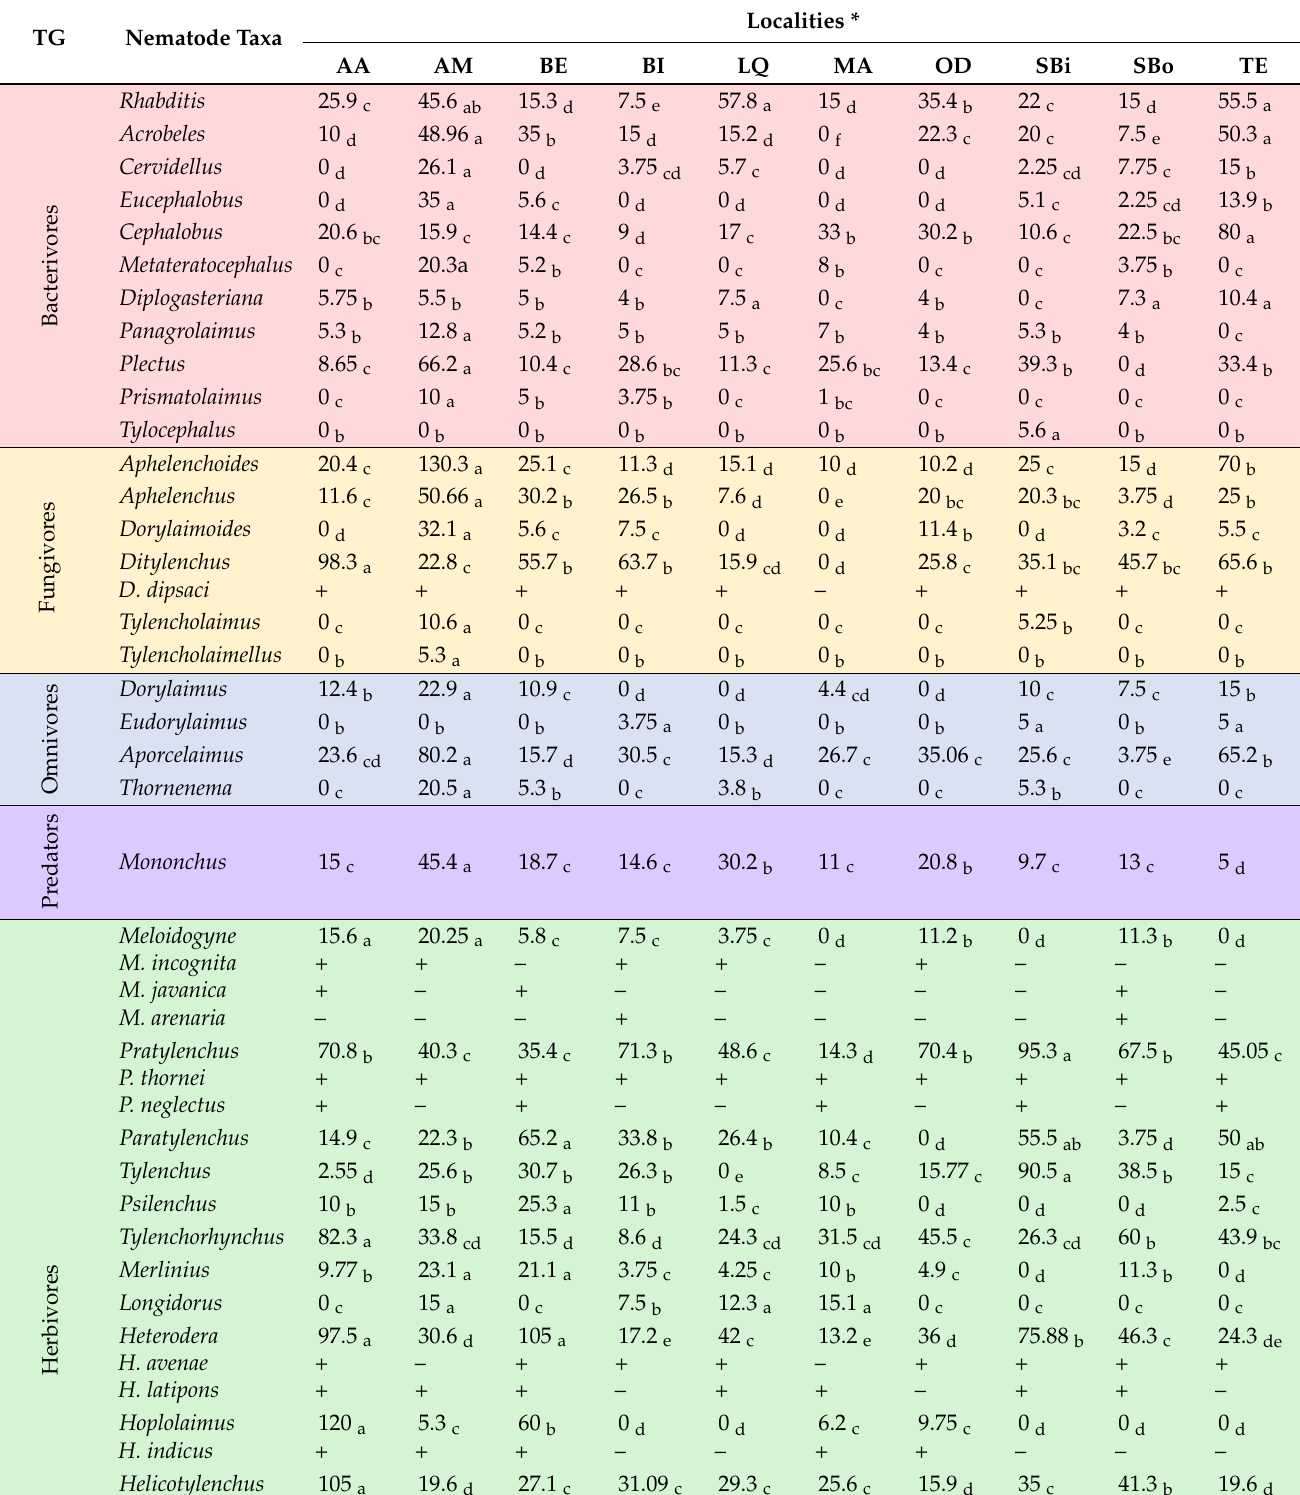
Table 3. Mean abundance values (100 cm 3 soil) –1 for all nematodes identified from wheat-growing areas in southern